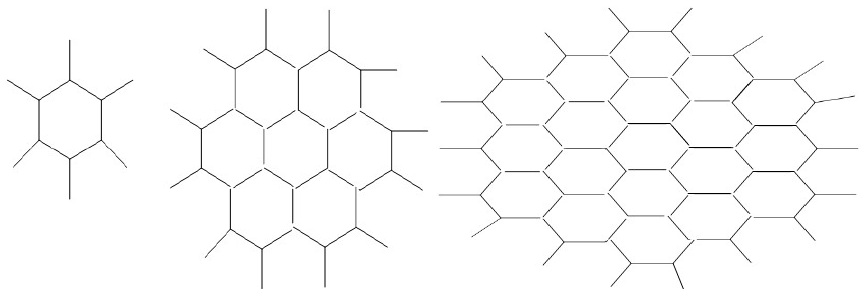
Fig. 12 A phenylene (PH) and its hexagonal squeeze